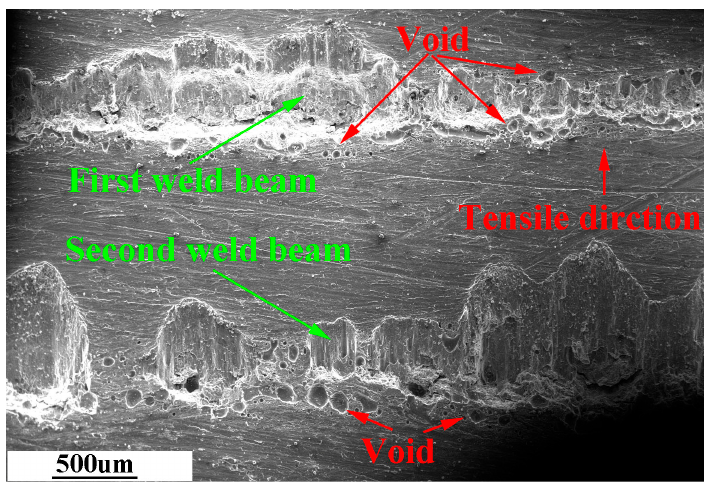
Figure 12. Morphology of the fracture surface on the aluminum side.